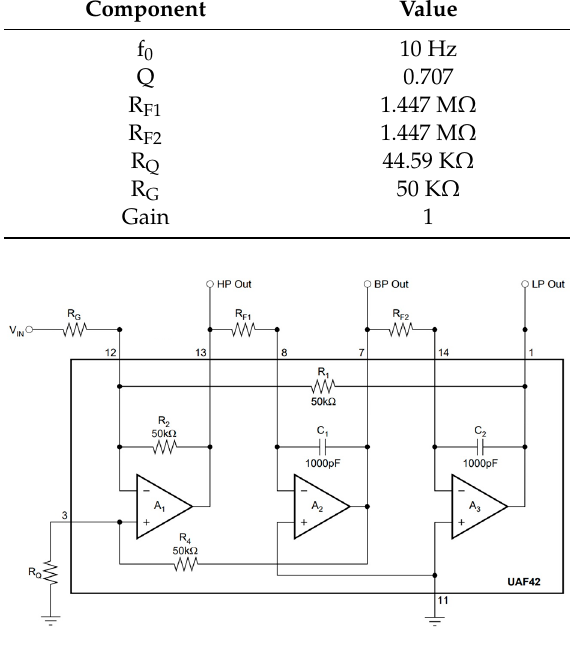
Figure 3. High-pass filter of 60 Hz with the UAF42. Table 2. Values obtained for the high-pass filter of 10 Hz with the Filter 42 program.